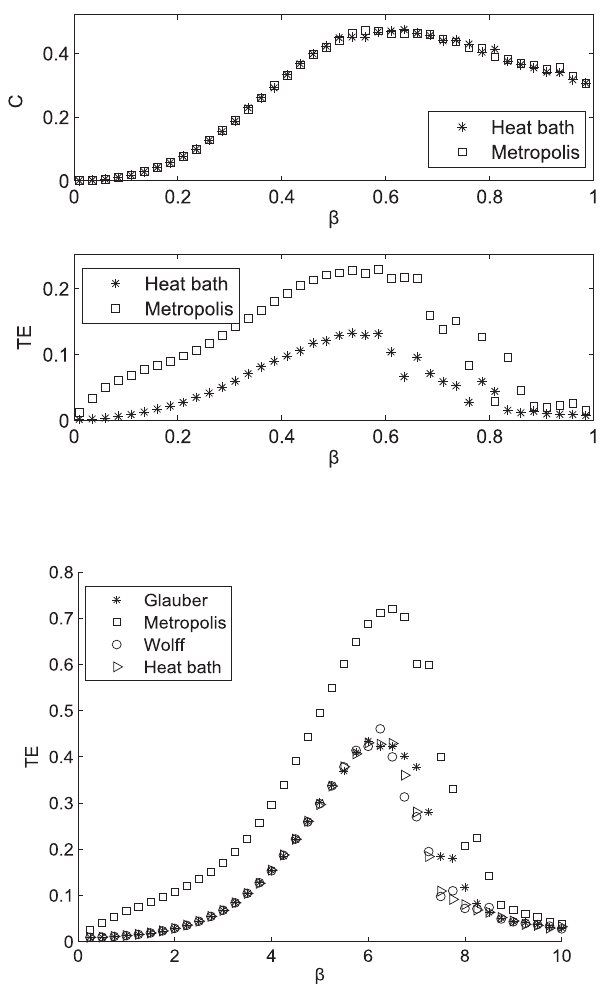
Figure 4. Ising model with different dynamics. a: Transfer Entropy versus the inverse temperature b for the Ising model implemented on the 66-nodes human connectome with four different dynamics (Glauber, Metropolis, Wolff and Heat Bath). b: Transfer Entropy versus the inverse temperature b for the Ising model implemented on an deterministic scale free network (81 nodes) with Heat Bath and Metropolis dynamics.